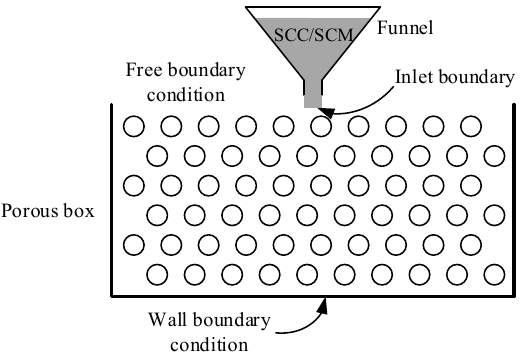
Figure 2. Illustration of pouring of self-compacting mortar (SCM) into the porous box and boundary condition of the numerical simulation.